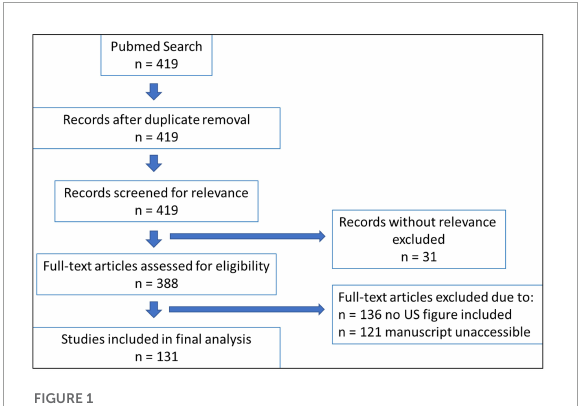
FIGURE1 Study selection process according to the PRISMA